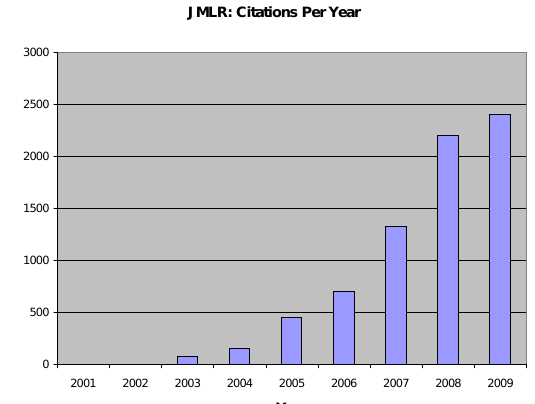
Figure 2: An exponentially increasing number of cita- tions for the Journal of Machine Learning